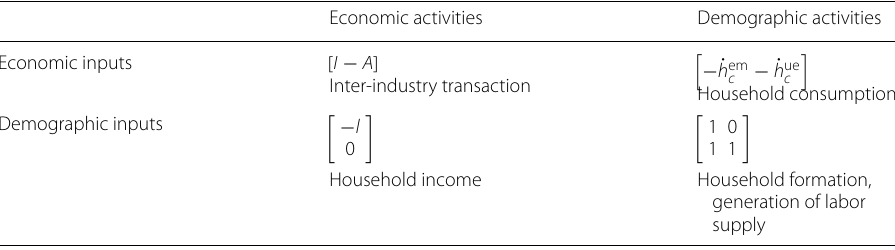
Table 1 System of input–output model for